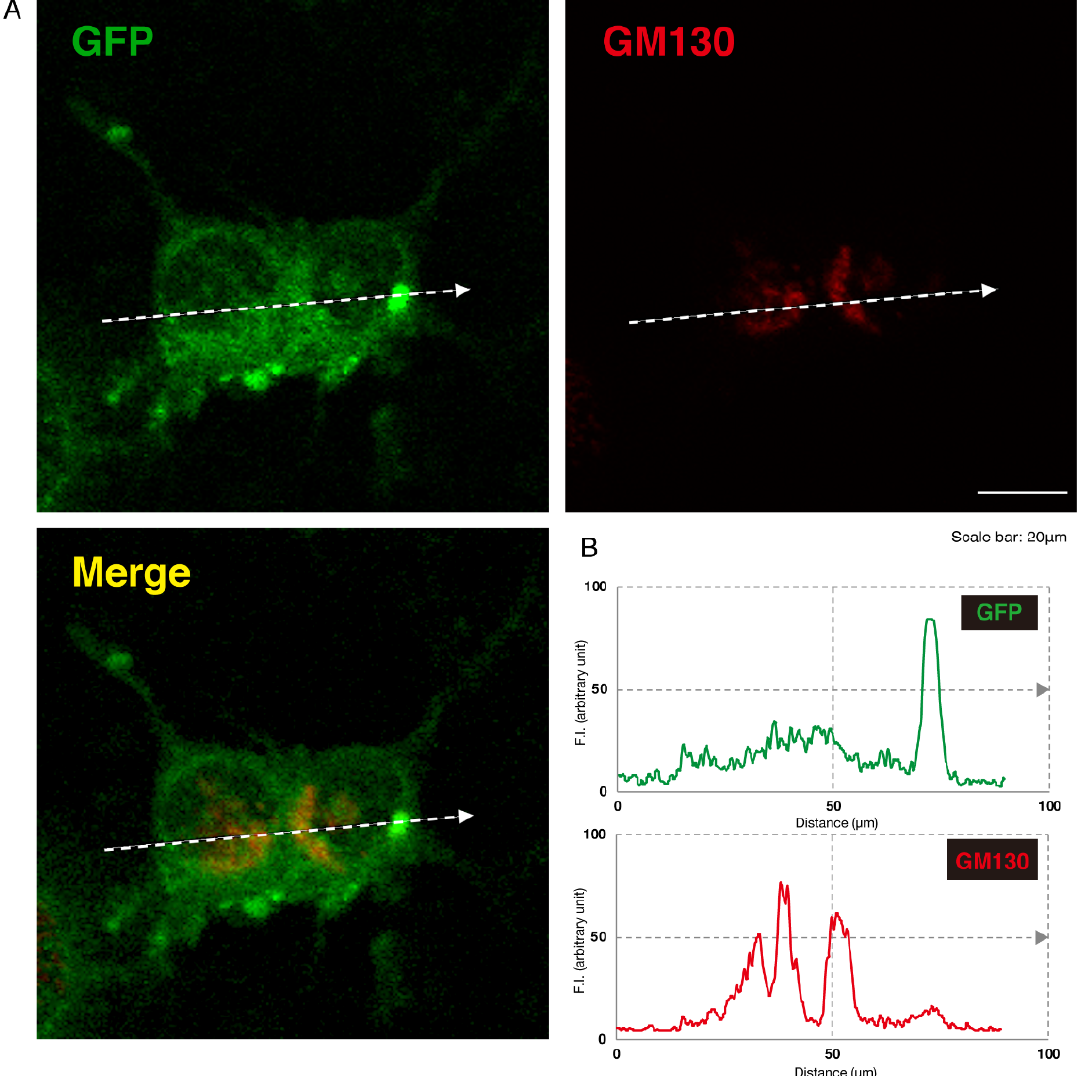
Figure 4. The 292CA mutant proteins are partially colocalized with the Golgi body marker. ( A ) N1E-115 cells were transfected with the plasmid encoding the 292CA mutant construct of GFP-tagged AIMP1 (green). Transfected cells were stained with an antibody against the Golgi body marker GM130 (red). A merged image with a dotted arrow is also shown in the bottom panel. The scale bar indicates 20 µ m. ( B ) Fluorescence intensities (F.I., arbitrary unit) of green and red colors are shown along dotted arrows in A.